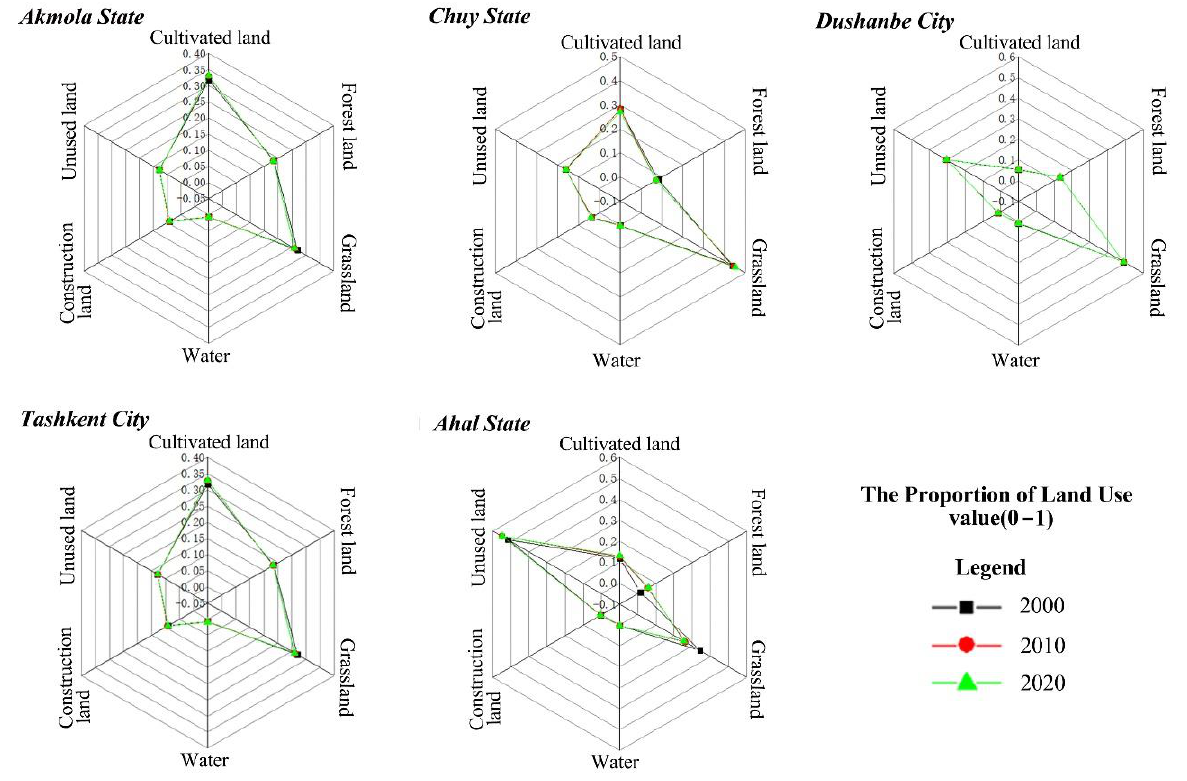
Figure 2. Proportion of land use types.